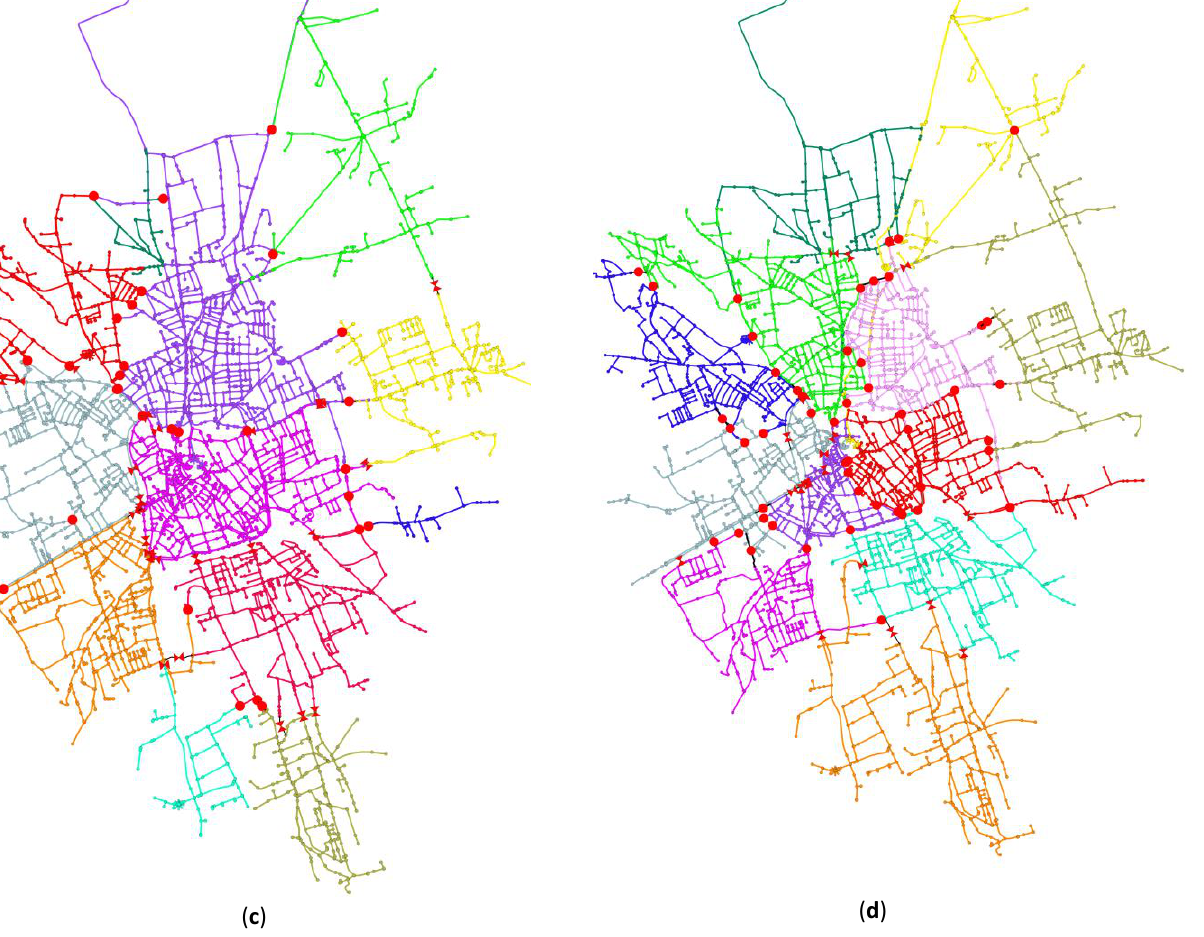
Figure 5. ( a ) Udine WDNP: Spectral clustering algorithm and investing cost objective function; ( b ) Udine WDNP: Girvan–Newman algorithm and investing cost objective function; ( c ) Udine WDNP: Spectral clustering algorithm and MRI objective function; ( d ) Udine WDNP: Girvan–Newman algorithm and MRI objective